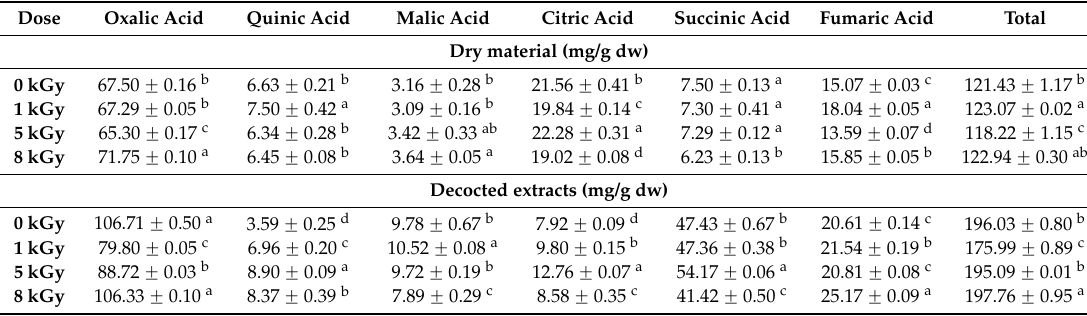
Figure 2. Chromatographic profile of organic acids in the decoction prepared from M. neglecta samples irradiated at 5 kGy, obtained using UFLC-PDA. Peak identification: 1: oxalic acid, 2: quinic acid, 3: malic acid, 4: citric acid, 5: succinic acid, and 6: fumaric acid. Table 1. Organic acids content in the dry material and decocted extracts of M. neglecta samples submitted to gamma